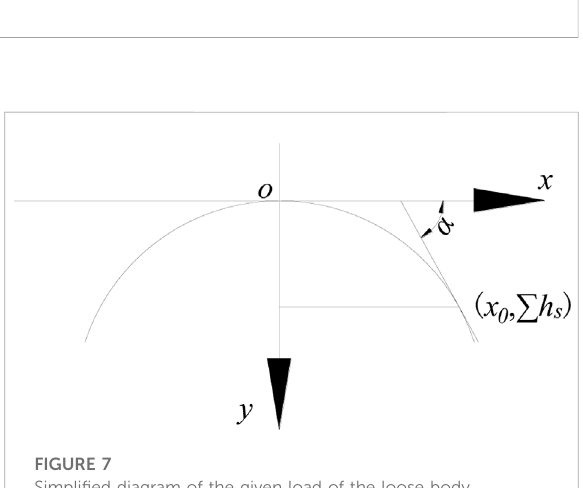
FIGURE 6 Roof structure characteristics after coal seam extraction.